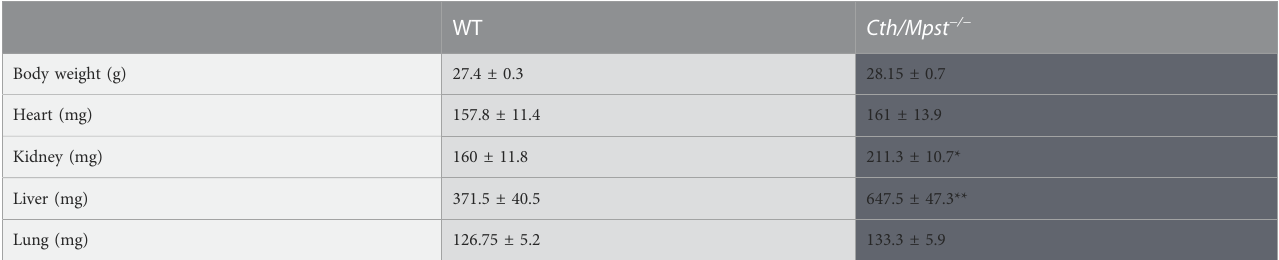
TABLE 1 Body and organs weight of WT and Cth/Mpst double knock out mice. Data are presented as means ± S.E.M., * p < 0.05 and ** p ≤ 0.01, N = 4 mice per